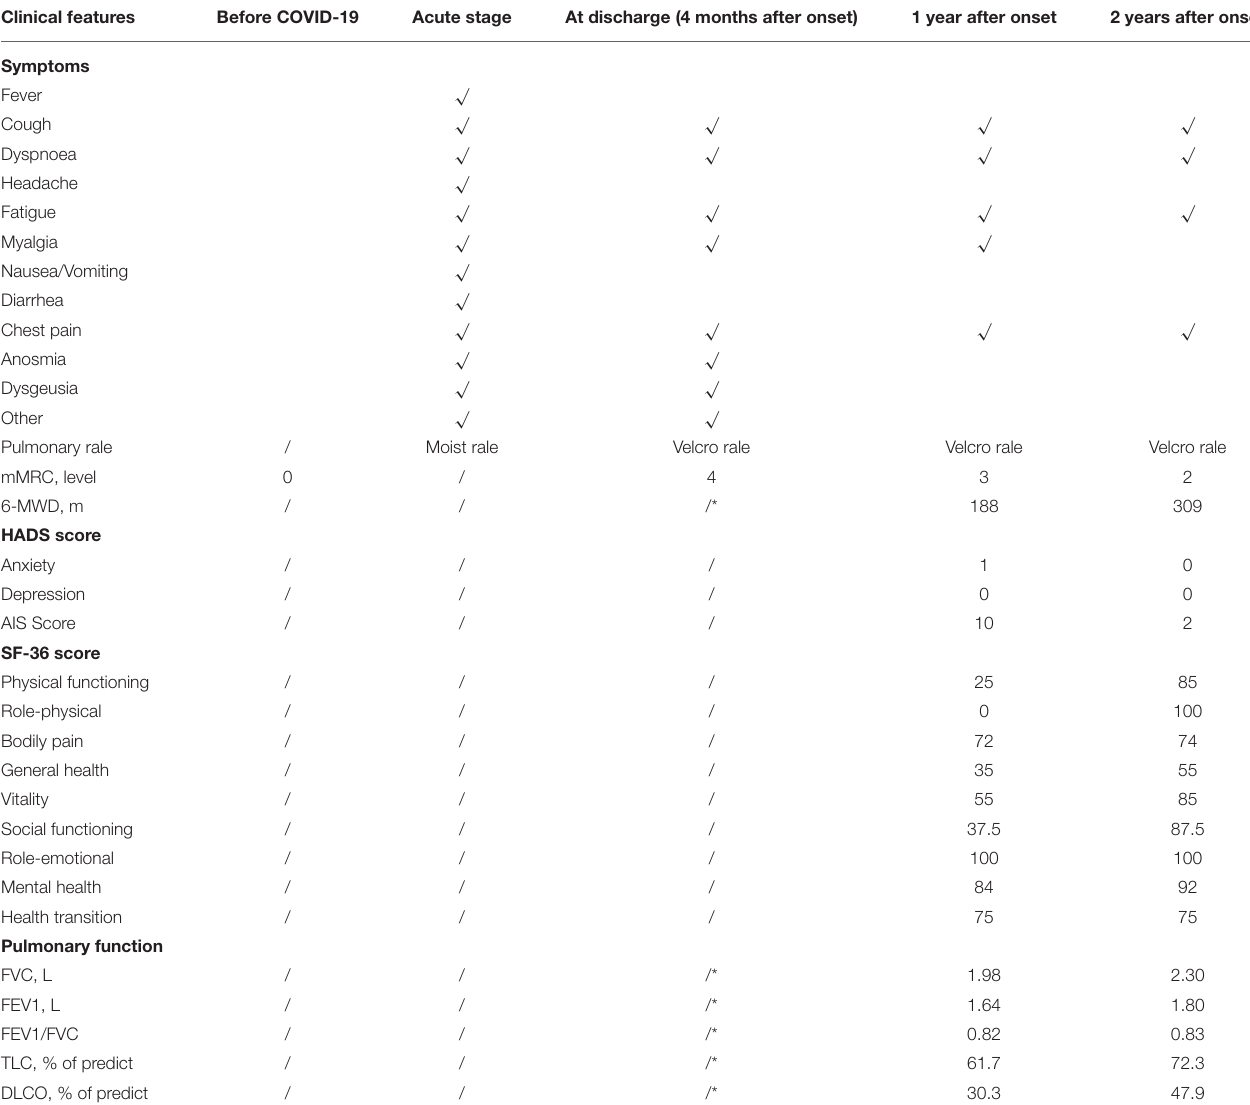
TABLE 1 | Evolution of clinical features from illness onset and taking pirfenidone (2 months after onset). Clinical